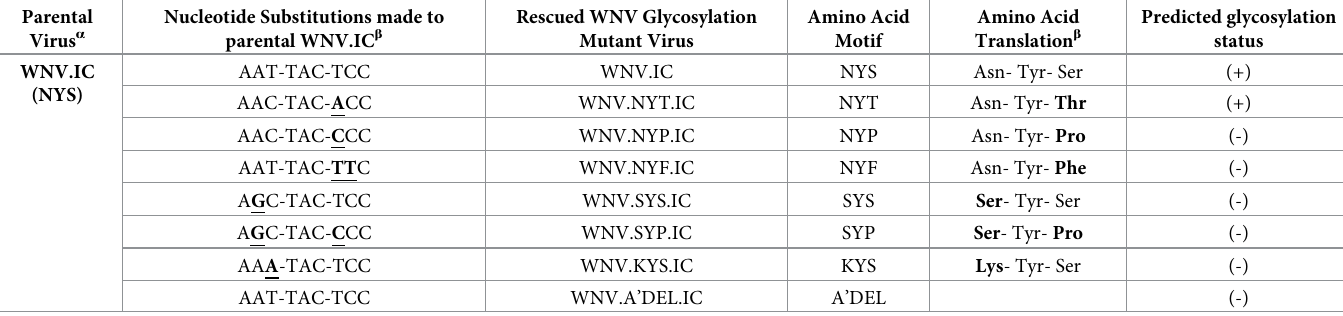
Table 2. Summary of West Nile virus infectious cDNA clone derived glycosylation mutant viruses that were generated. Nucleotide Substitutions made to Parental parental WNV.IC Virus α